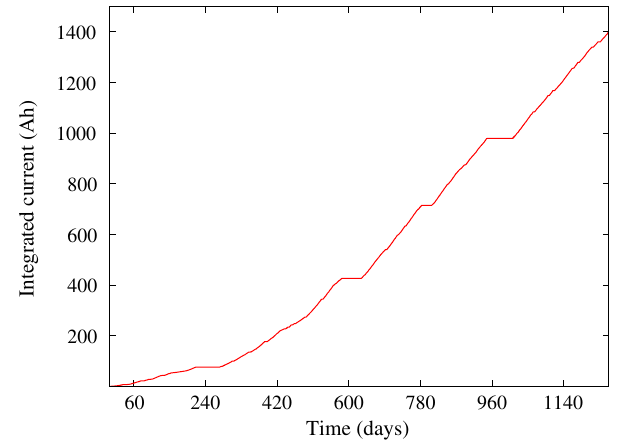
FIG. 3. Integrated beam current of PETRA III. The time scale starts at May 1, 2009, and ends at October 22,